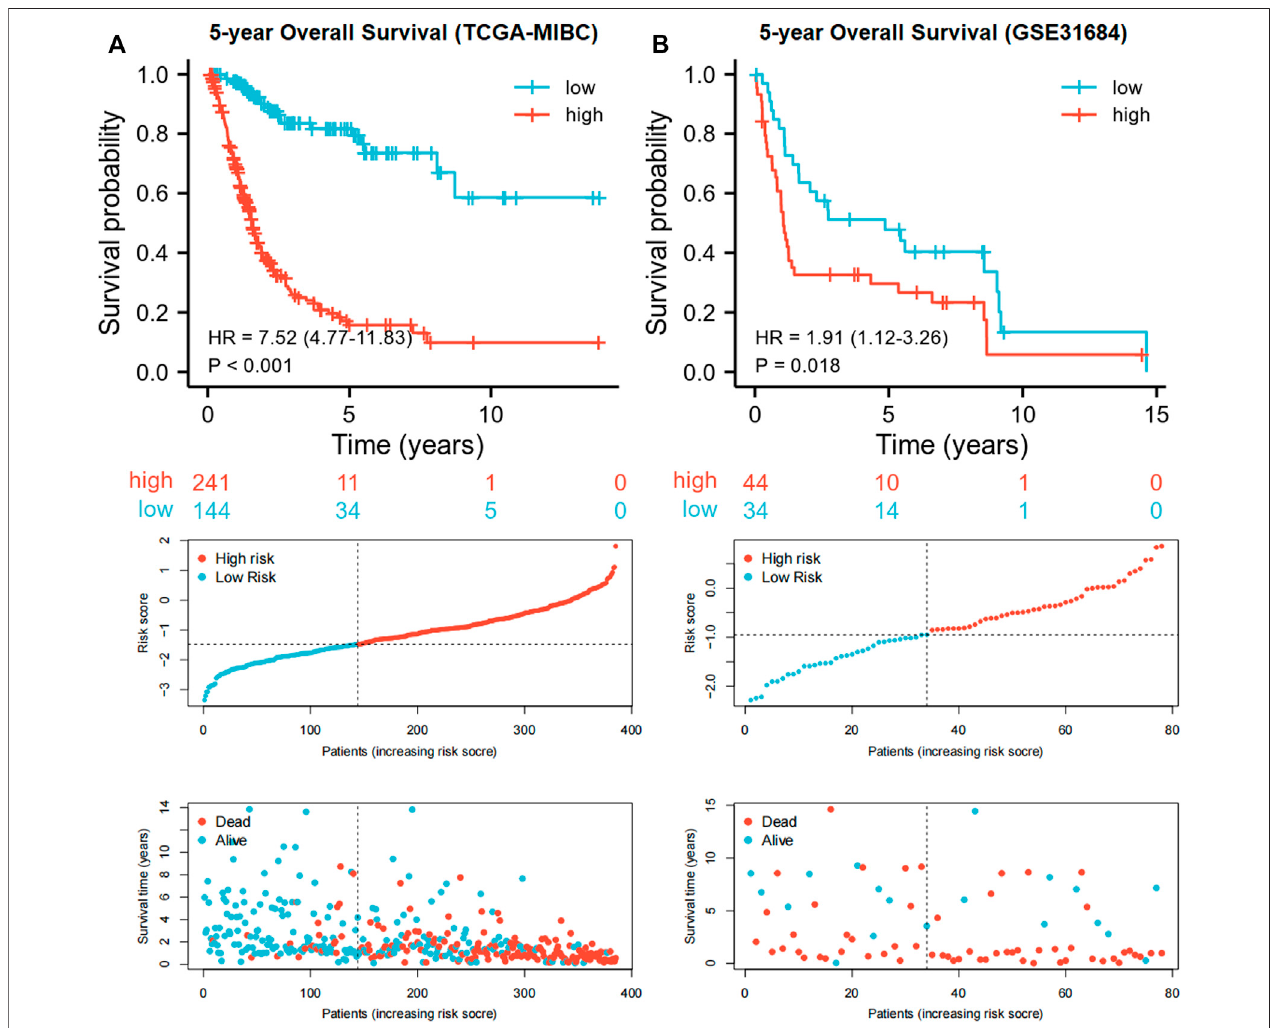
FIGURE 1 | Kaplan – Meier curves and risk plots comparing the overall survival between high-risk and low-risk groups according to the 45-IRGP signature in the training cohort (A) and validation cohort (B) .